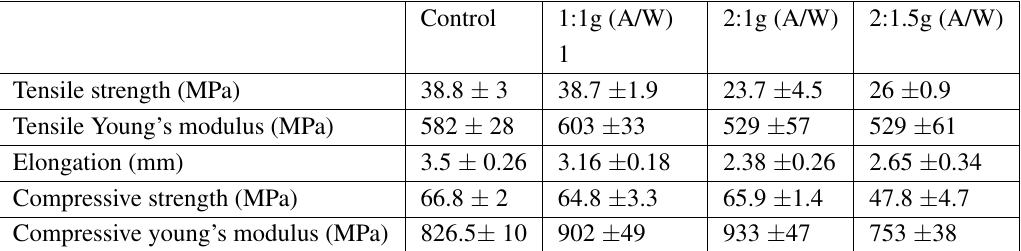
Table 2. Mechanical properties of PMMA-Acetone/Water (A/W) compositions